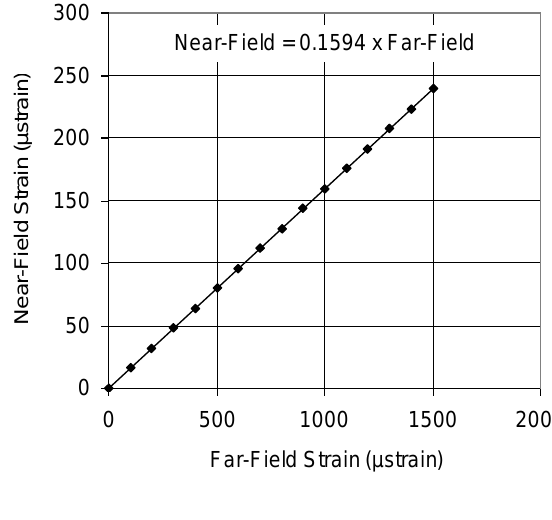
Figure 16. Relation between far-field strain and near-field strain. The transferred (near-field) strain is ~16% from the applied (far-field) strain. Near-Field = 0.1594 x